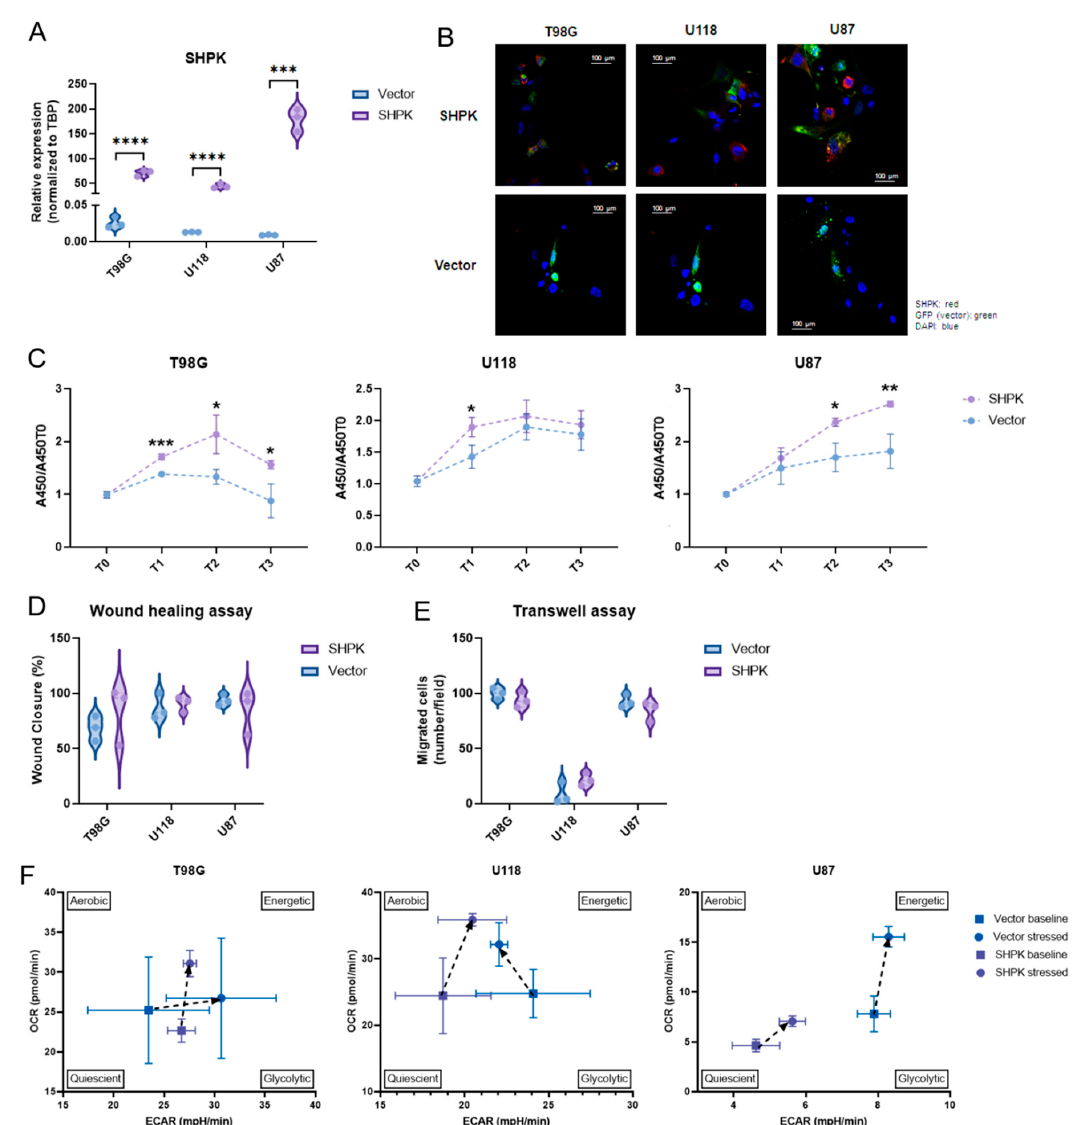
Figure 3. SHPK overexpression and cell functional studies. ( A ) SHPK mRNA expression in T98G, U87, and U118 cells after SHPK overexpression and relative controls. ( B ) Immunofluorescence staining of SHPK protein (red) in T98G, U87, and U118 cells overexpressing SHPK and relative controls (vector alone, green). Nuclei were stained with DAPI (blue). ( C ) Viability of T98G, U87, and U118 cells after SHPK overexpression and their controls at the time of seeding (T0) and after 24 h (T1), 48 h (T2), and 72 h (T3). A450 absorbance values relative to T0 are shown in the vertical axis ( y ). ( D ) Wound healing assay of T98G, U87, and U118 cells after SHPK overexpression and relative controls. ( E ) Transwell migration assay of T98G, U87, and U118 cells after SHPK overexpression and relative controls. Cells that crossed the membrane were counted in five visual fields as migrated